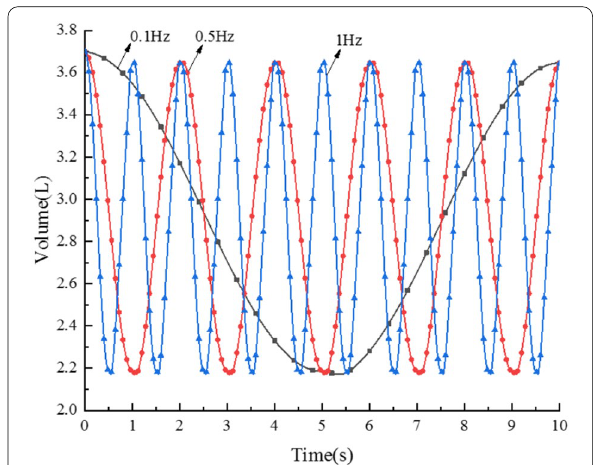
Figure 18 Changes in volume at different frequencies